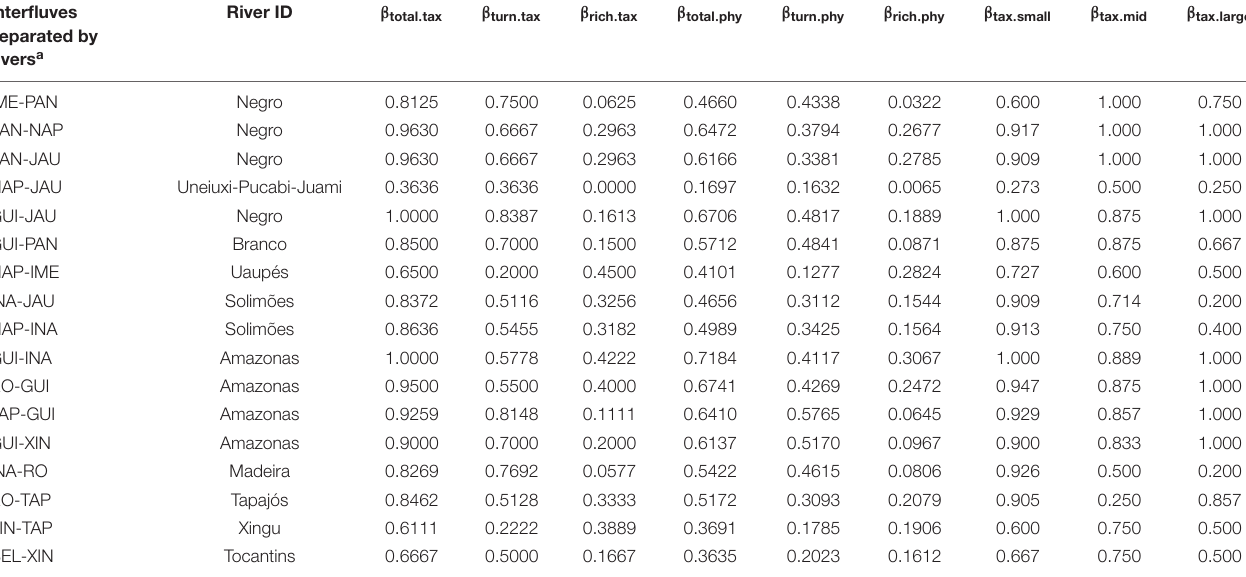
TABLE 1 | Primate β -diversity in the 10 major biogeographic provinces along the Amazonia. Interfluves separated by rivers a